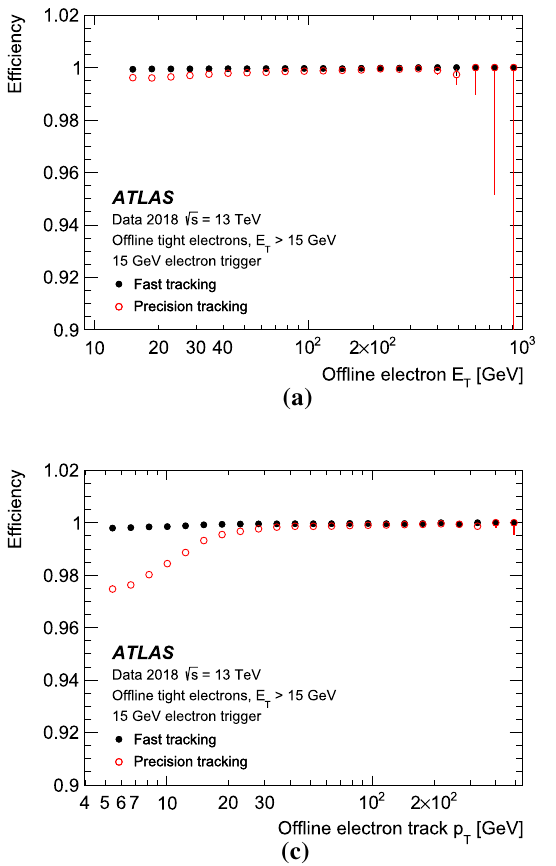
Fig. 27 The efficiency versus transverse energy of the electron candi- date from the tag and probe analysis of the 15 GeV trigger with respect to a the offline electron transverse momentum, b the offline electron E T / p T , and c the offline electron track p T . Shown in d is the distri-